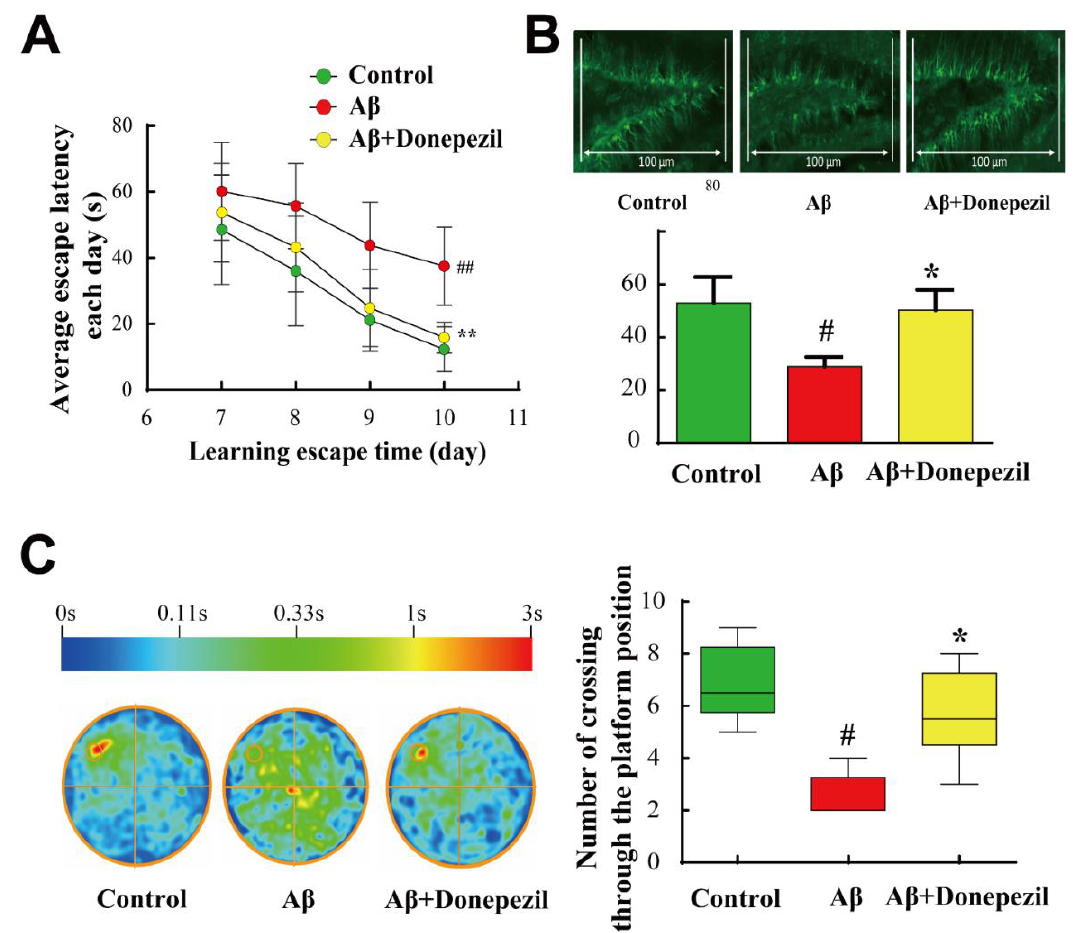
Figure 1. ( A ) Morris water maze test. The escape latency of mice on days 7 – 10 was recorded. ( B ) Doublecortin-positive cells in the dentate gyrus region. ( C ) Number of platform area crossings was determined by conducting a probe test at the end of day 10. The color scale indicates the average position distribution time of animals within each group. Data are presented as the mean ± standard error of the mean values of sextuple determinations. #, p < 0.05; ##, p < 0.01 vs. control group; *, p < 0.05; **, p < 0.01 vs. amyloid β (A β ) group. Therefore, we selected the dentate gyrus region to study the physiology of neuronal cells in the hippocampal region and determined the effect of donepezil on an anatomical scale. As doublecortin is a common marker of neurogenesis, this antibody was used to survey neuronal conditions in the dentate gyrus. The results showed that A β 25–35 intracerebroventricular (ICV) injection decreased the number of doublecortin-positive cells in the dentate gyrus, whereas donepezil treatment of A β -injected mice increased it by 2-fold (Figure 1B). The results of crossover time in the probe test showed that A β 25–35 treatment caused cognitive dysfunction, and donepezil resulted in the successful recovery of memory impairment (Figure